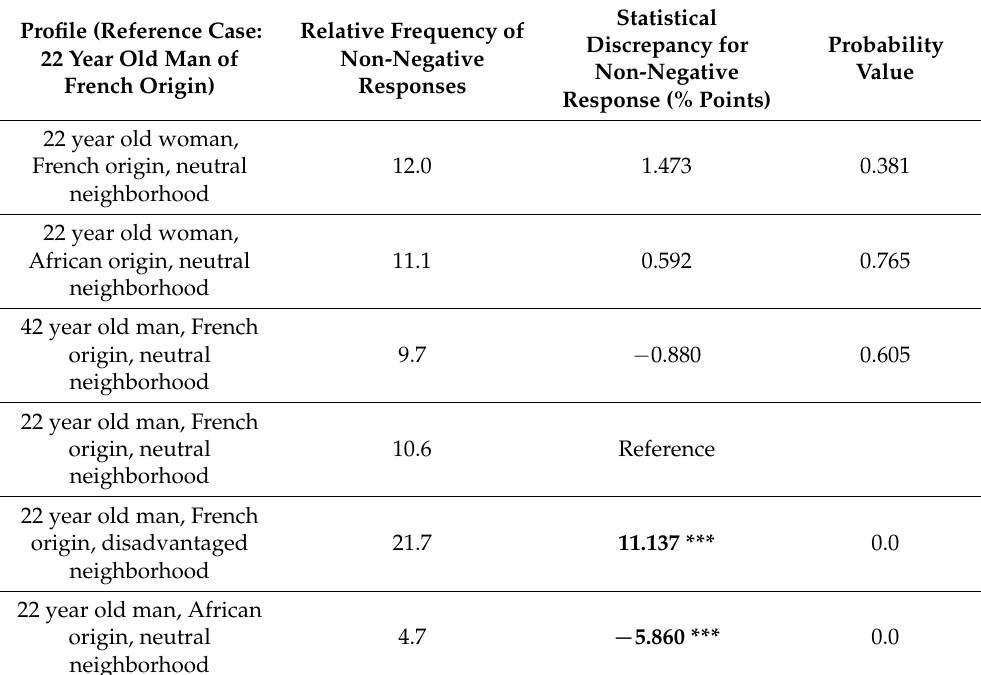
Table 2. Differences in the non-negative response rate emanating from the same business for sale offers (estimated discrimination parameters) (reference profile: 22 year old man, French